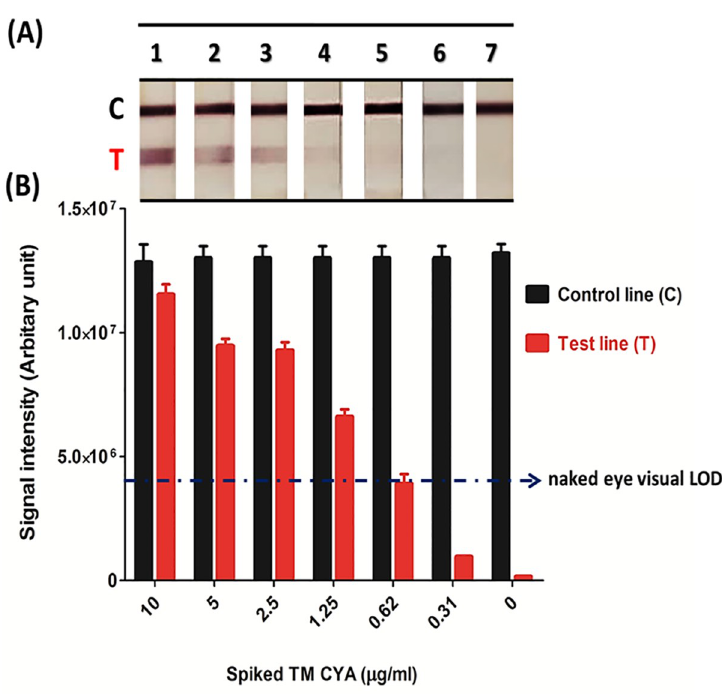
Fig 6. Lower limit of detection (LOD) of the GNA-MAb 4D1 sandwich ICT strip. Normal urine samples from healthy individuals were spiked with TM CYA at the indicated concentrations from 10–0.31 μ g/ml. (A) Visual observation, A-G labels represented the concentrations of TM CYA from 10, 5, 2.5, 1.25, 0.62, 0.31, and 0 μ g/ml, respectively, which be compatible with TM CYA concentrations that demonstrated in the below graph. (B) Densitometric analysis using UVP vision scanner and image J software. (Abbreviations indicated C: control line, T: test line).